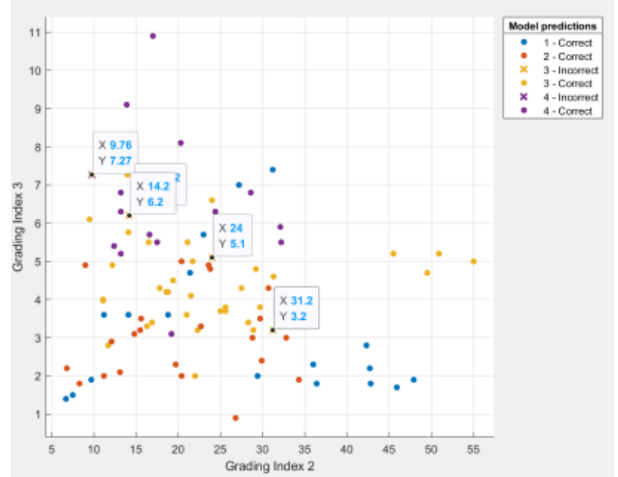
Figure 7. Scatter diagram of prediction results in low dimension (3).